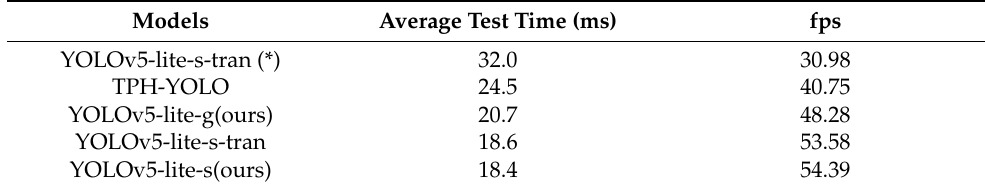
Table 3. Comparison of the real-time performance.